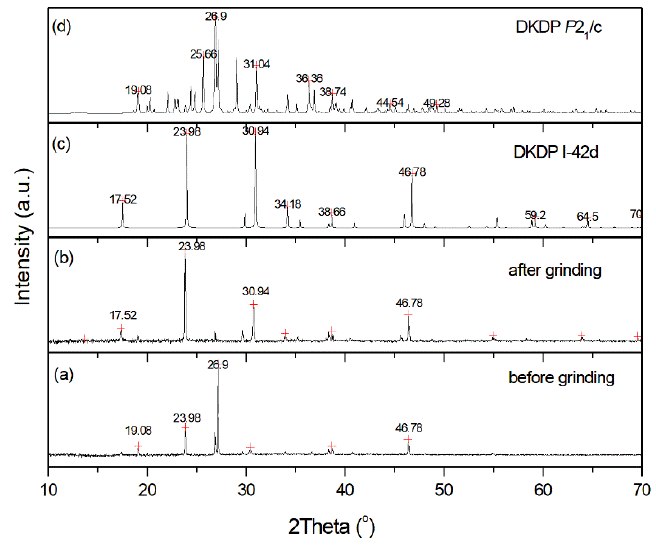
Figure 5. Comparison of XRD spectra of the DKDP monoclinic single-crystalline fibers before and after grinding. ( a ) the DKDP single-crystalline fibers on the substrate before grinding. ( b ) the DKDP single-crystalline fibers on the substrate after grinding. ( c ) the XRD spectra of tetragonal I -42d DKDP crystal phase. ( d ) the XRD spectrum of the monoclinic P 2 1 / c DKDP crystal phase.